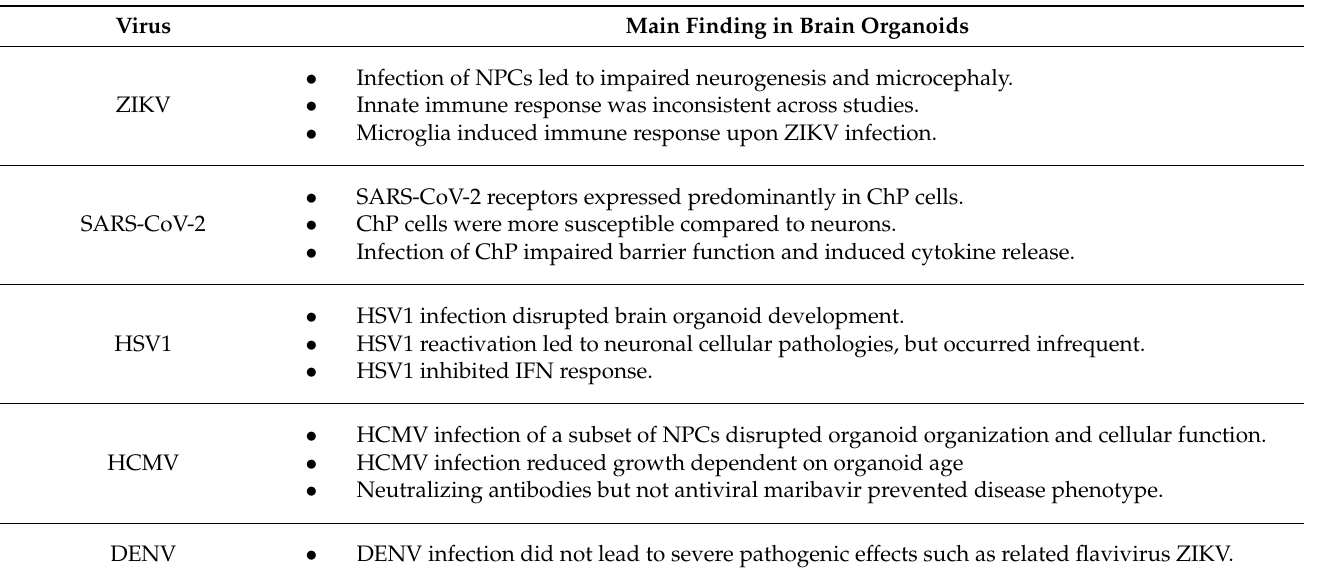
Table 2. Main findings of studies on ZIKV, SARS-CoV-2, HSV1, HCMV, and DENV using brain